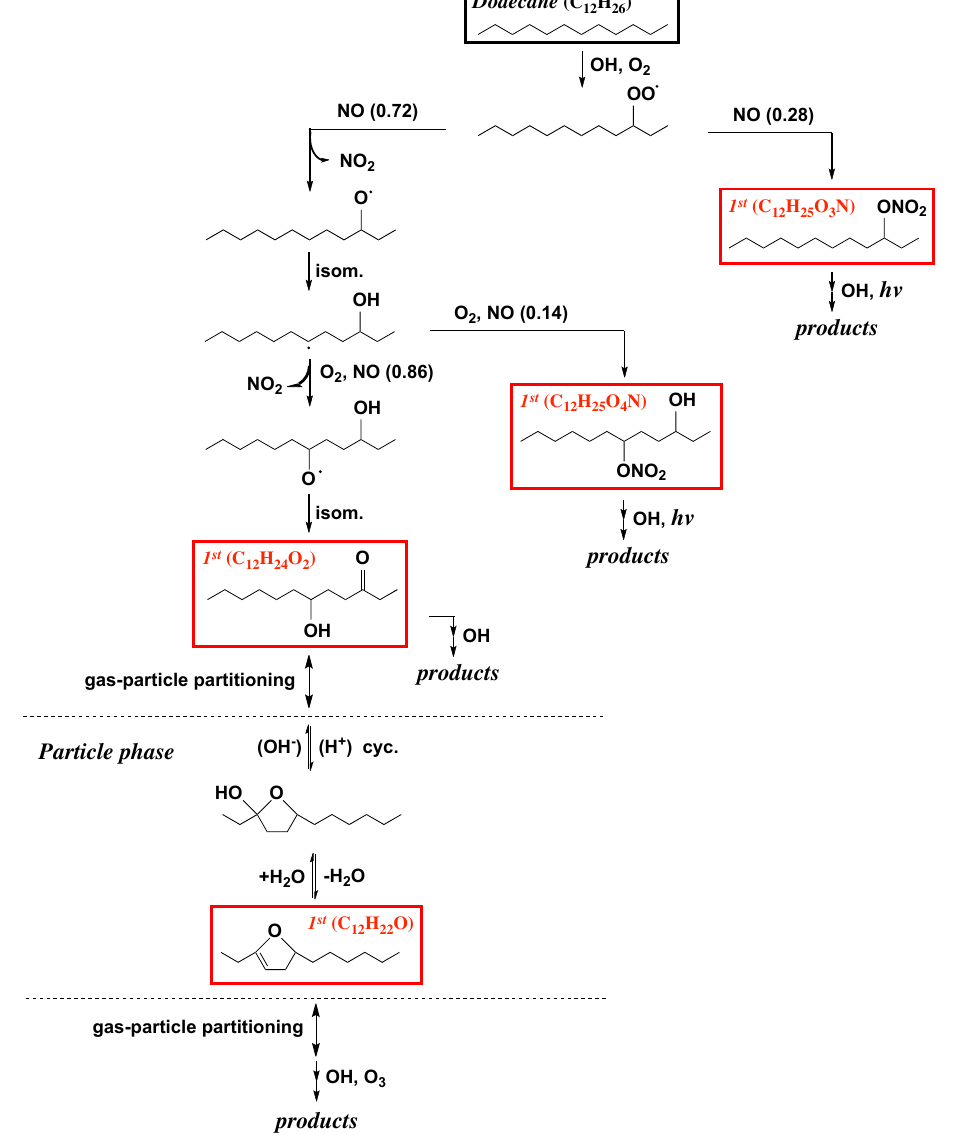
Fig. 1a. Schematic mechanism for the photooxidation of dodecane under high-NO x conditions. Note that only first-generation products are shown here. The boxes indicate compounds and associated reaction pathways incorporated in the model simulation.